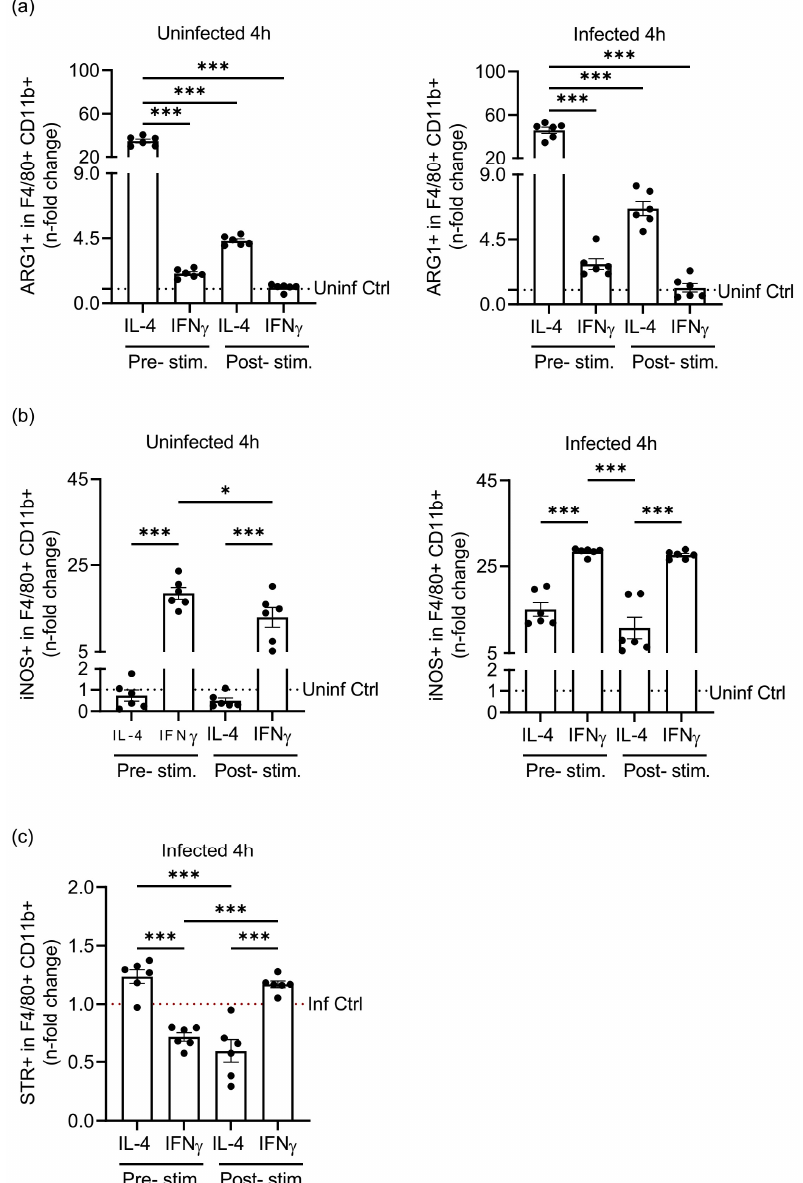
Figure 5. Pre- or post-stimulation of macrophages with IL-4 and IFN γ impacts the amount of S .tm phagocytosed by F4/80 + CD11b + macrophages. Unpolarised BMDM and pre-stimulated polarised BMDM (2 ng/mL IL-4 or 20 ng/mL IFN γ ) were infected with S .tm expressing RFP (STR) for 1 h. Unpolarised cells were then stimulated (post-stimulation) with 10 ng/mL IL-4, 100 ng/mL IFN γ or left unstimulated for 4 h. Percentages of ARG1, iNOS and STR in macrophages were analysed via flow cytometry. ( a ) Percentage of ARG1-positive cells in F4/80 + CD11b + cells in pre-stimulated compared to post-stimulated BMDM. Data shown for uninfected (left) and infected (right) cells. ( b ) Percentage of iNOS positive cells in F4/80 + CD11b + in pre-stimulated compared to post-stimulated BMDM. Data shown for uninfected (left) and infected (right) cells. ( c ) Percentage of STR positive cells in F4/80 + CD11b + cells in infected pre-stimulated compared to post-stimulated BMDM. Statis- tical significance was determined by one-way ANOVA with Tukey post hoc test. * p -value < 0.05; *** p -value < 0.001. Representative data (mean ± SEM) from three independent experiments with two technical replications are shown. Data were normalised to the unstimulated uninfected Ctrl or, as indicated, to the unstimulated infected